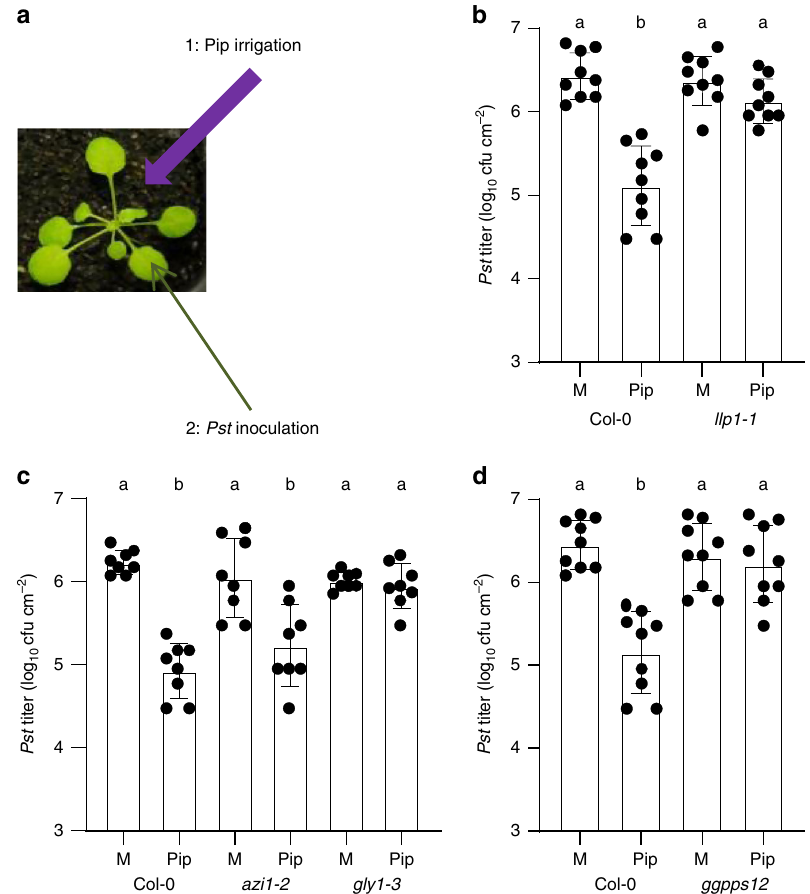
Fig. 2 LLP1, glycerol-3-phosphate (G3P), and volatile monoterpenes act downstream of pipecolic acid (Pip) in Pip-induced resistance. a Setup of a Pip irrigation experiment. Plants were irrigated near the roots with Pip (or H 2 O as the mock (M) control) and subsequently inoculated in the leaves with Pst . b , c In planta Pst titers at 4 dpi of Pip- or mock-treated plants. The plant genotypes are indicated below the panels and include gly1-3 with compromised G3P accumulation and ggpps12 with compromised monoterpene biosynthesis. Dots indicate individual results from three biologically independent experiments per genotype and treatment (including three replicates each). Bars represent the average of the indicated results ± standard deviation. Different letters above bars indicate signi fi cant differences, one-way ANOVA, P <